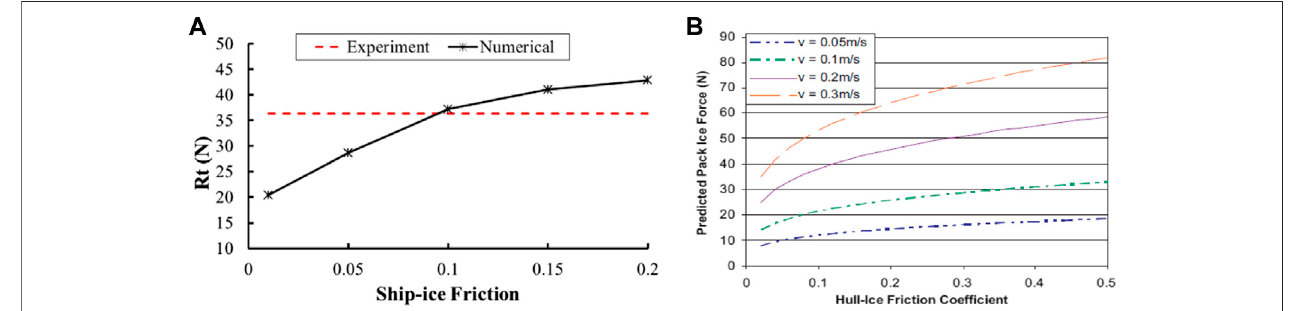
FIGURE 13 | In fl uence of ship – ice friction coef fi cient on ice resistance.